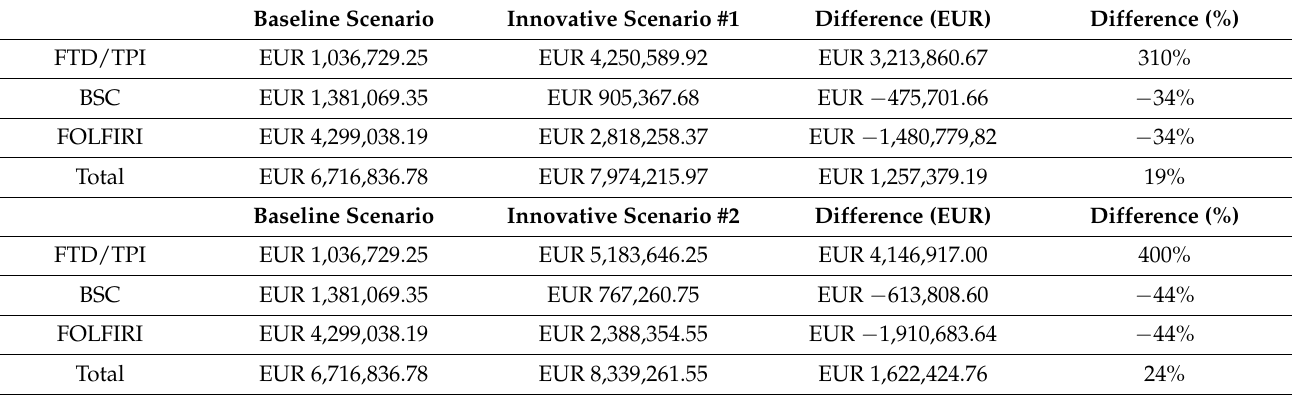
Table 5. Budget impact analysis.